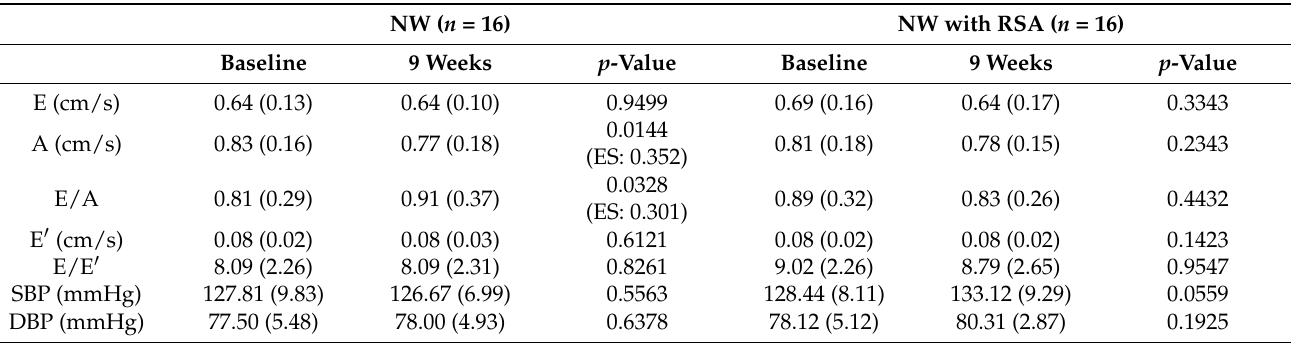
Table 2. The echocardiogram examination parameters and blood pressure of the groups subjected to the study.